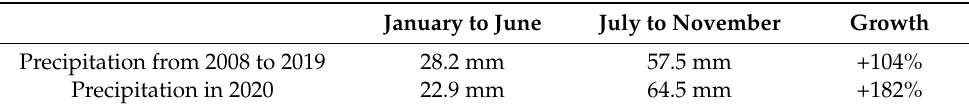
Table 8. Comparison of actual precipitation in Wushaoling.